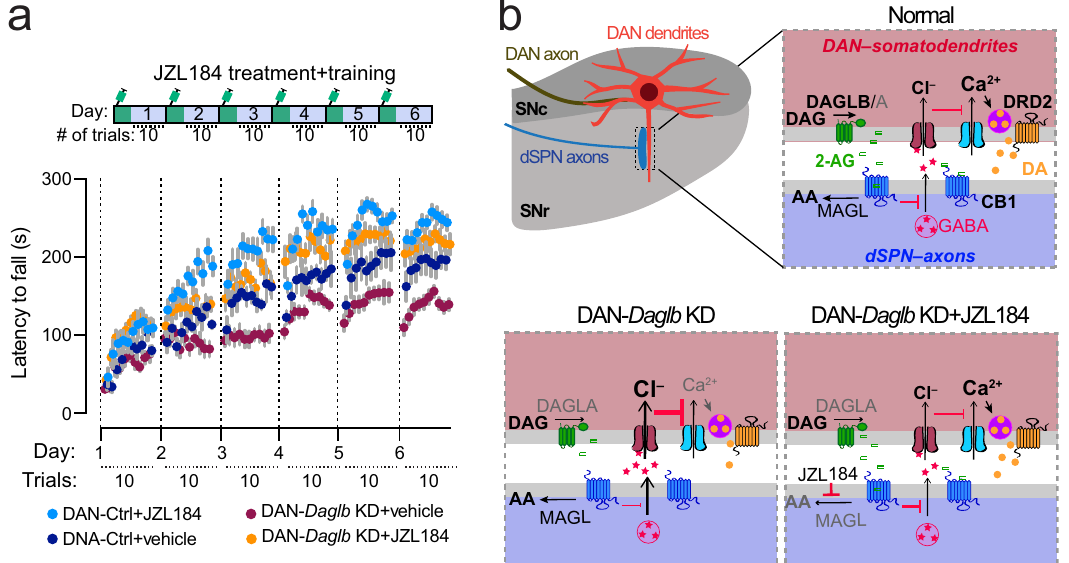
Fig. 8 JZL184 treatment rescues the locomotor skill learning impairments of DAN- Daglb KD mice. a Rotarod locomotor skill learning of DAN-control ( n vehicle = 7, 4M/3F; n JZL184 = 10, 5M/5F) and DAN- Daglb KD ( n vehicle = 11, 6M/5F; n JZL184 = 12, 6M/6F) mice treated with vehicle or JZL184 (20 mg/kg). Data were presented as mean ± SEM. b A working model of nigral DAN-derived 2-AG signaling in regulating DAN neuron activity and dopamine release in SN region, where 2-AG modulates DAN calcium in fl ux and somatodendritic dopamine release through retrograde inhibition of presynaptic GABA release from dSPNs via CB1-mediated intracellular signaling pathway. Genetic deletion of Daglb in DANs compromises the 2-AG-mediated feedback regulation, while pharmacological inhibition of 2-AG degradation by JZL184 restores the signaling. Our study suggests that this nigral DAN-derived 2-AG signaling in the SN is involved in regulating the across-session locomotor skill learning. DAG diacylglycerol, DA dopamine, AA arachidonic